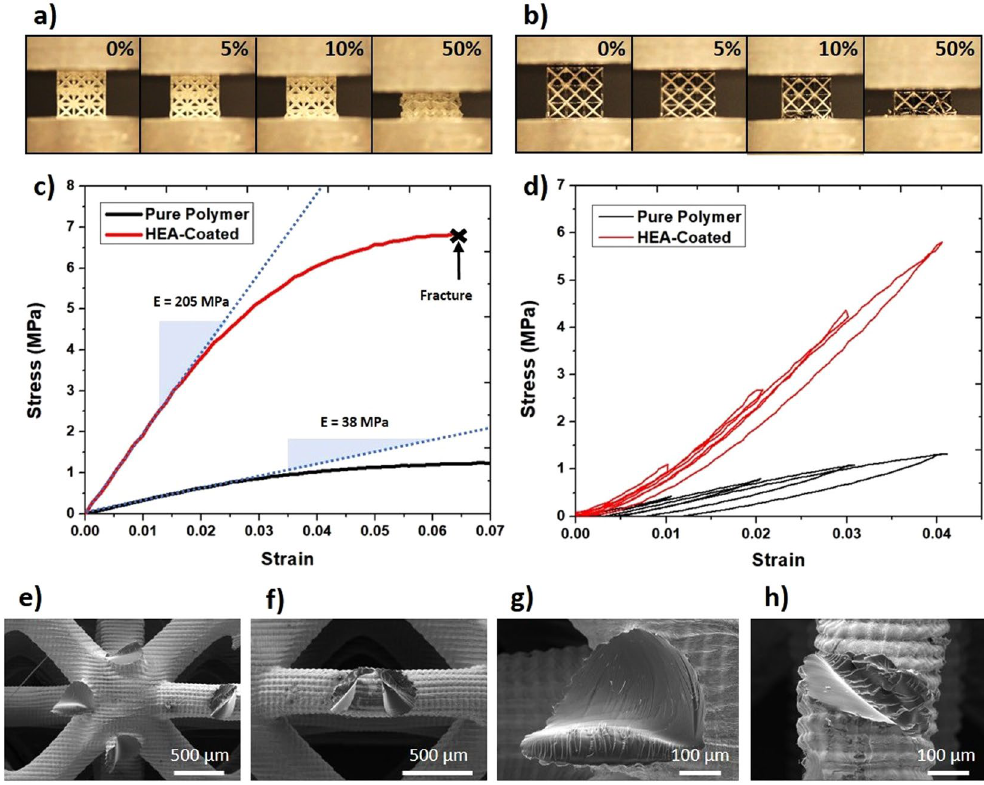
Figure 5. Finite element analysis (FEA) of the polymer and composite microlattices. ( a ) Contour plot of the meshed 3 × 3 × 3 FCC structure using a 10-node quadratic tetrahedral elements after uniaxial compression. ( b ) Enlarged view of the area with highest stress concentration. ( c ) Stress propagation on the FCC microlattice as its compressed. The direction of the arrow indicates the stepwise progression of the displacement from the top surface. ( d and e ) Stress distribution on the polymer and HEA coating of the composite microlattice representative unit cell,